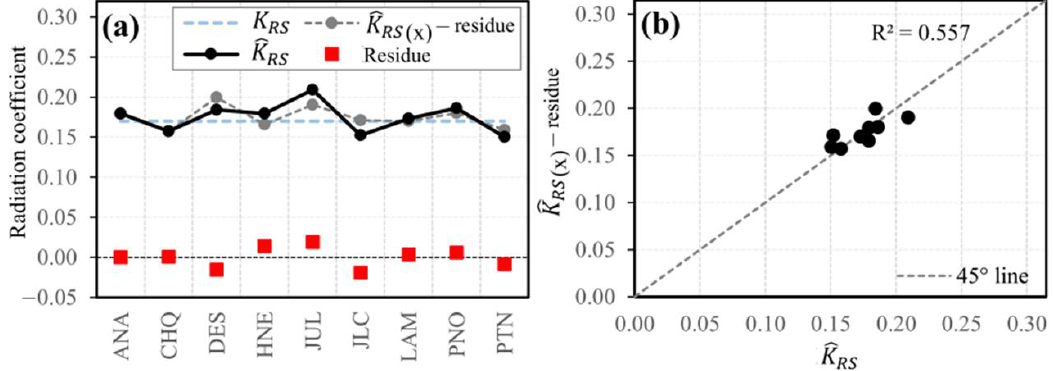
Figure 6. Regionalization of the calibrated radiation coefficient ˆ K RS of the HS equation as a function of longitude, latitude and altitude: ( a ) variation of the original K RS , ˆ K RS calibrated, ˆ K RS ( x ) − residue and residuals; ( b ) scatterplot between ˆ K RS and ˆ K RS ( x ) − residue interpolated without addition of the residual.